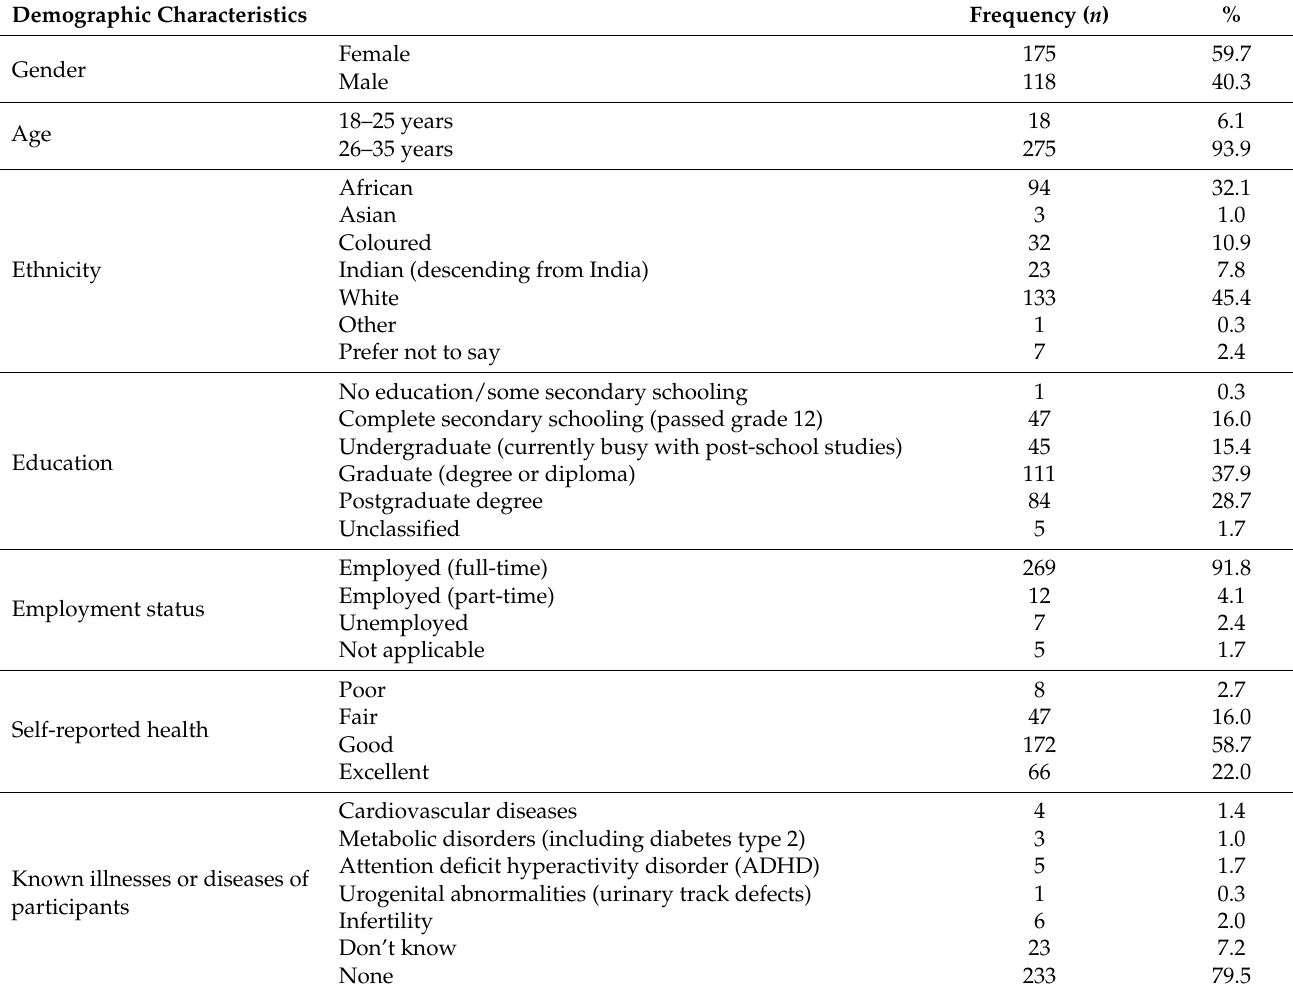
Table 2. Frequencies and distributions of participants’ self-reported demographics and